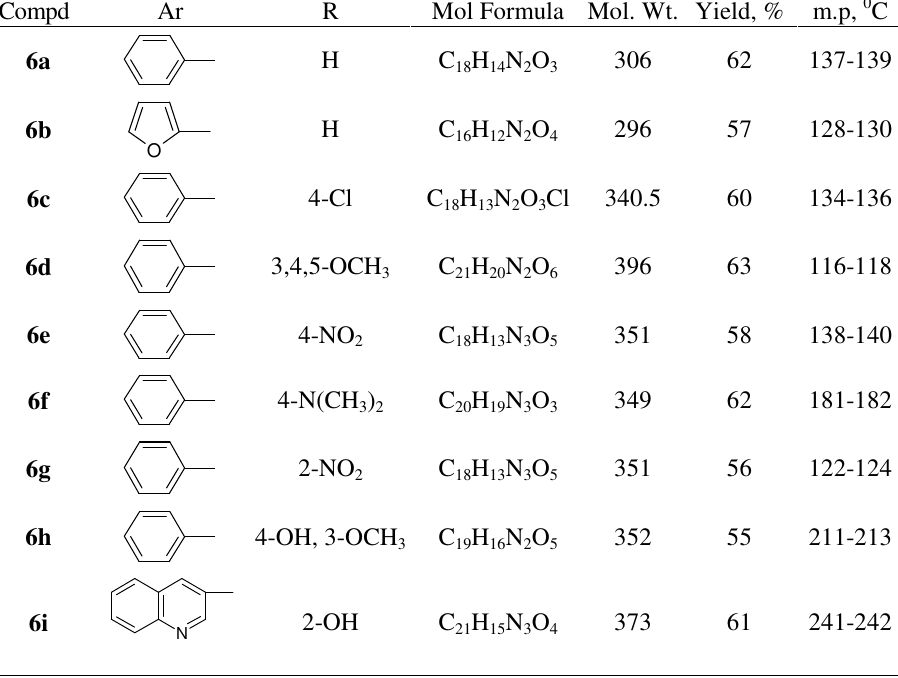
Table 1. Physical data and yields of 4-[1-oxo-3- (substituted aryl)-2-propenyl]- 3-(4- methylphenyl) sydnones ( 6a-i )